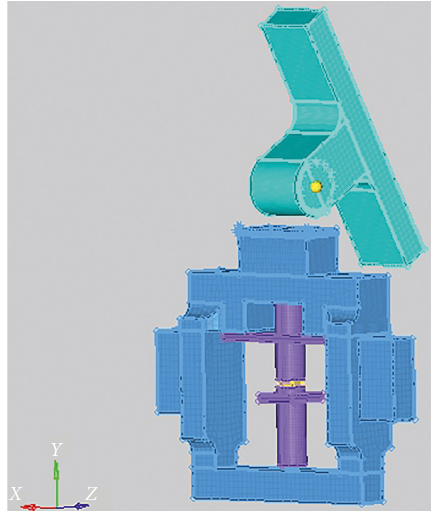
Figure 14: Simplified simulation model of the stress wave verification